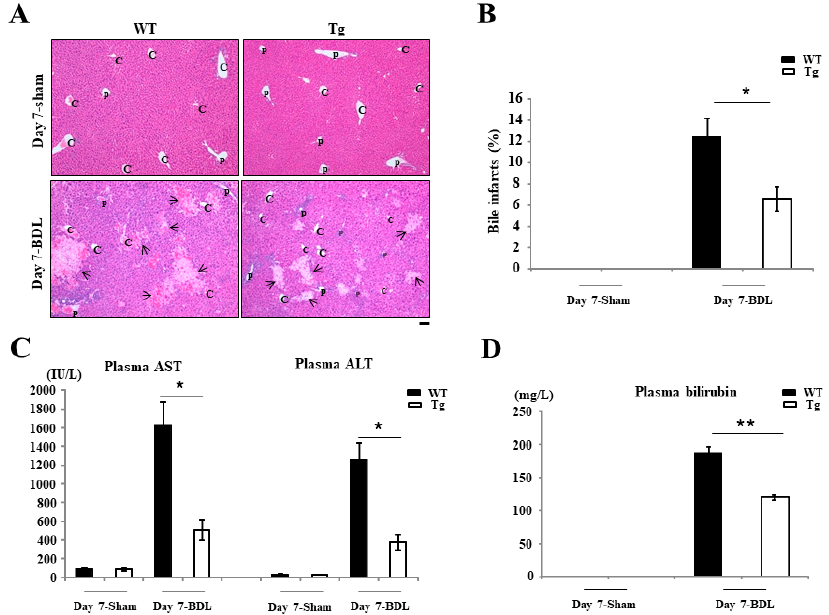
Figure 1. Histologic and serum analyses in mice. ( A , B ) The liver necrotic area of hPRDX4 ‐ Tg mice at day 7 after bile duct ligation (BDL) surgery was significantly smaller than in C57BL/6J wild ‐ type (WT) mice. No liver necrotic areas were found in sham mice. C, central vein; P, portal vein; arrows, necrotic areas. ( C ) The serum levels of aspartate aminotransferase (AST) and alanine aminotransferase (ALT) in hPRDX4 ‐ Tg mice were significantly lower than in WT mice on day 7 after BDL surgery. ( D ) Similarly, the plasma total bilirubin level was significantly lower in PRDX4 ‐ Tg mice than in WT mice on day 7 after BDL surgery. p Values were calculated using Welch’s t ‐ test. The values represent the mean ± SD. Bar = 100 µm * p < 0.05, ** p < 0.001, n =